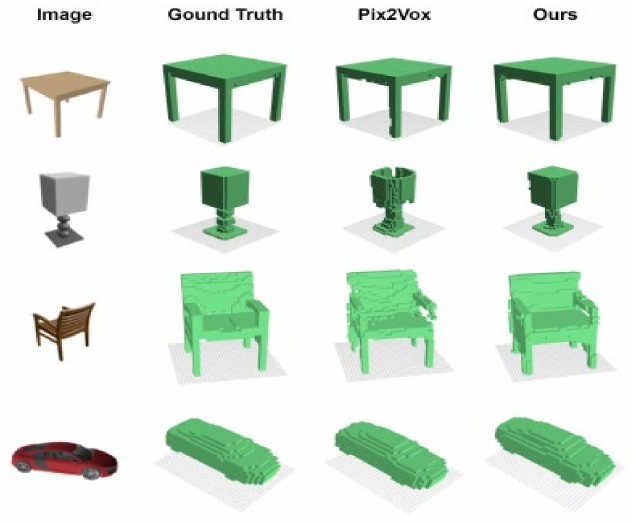
Figure 8. Visual comparison of our approach with Pix2Vox for four test